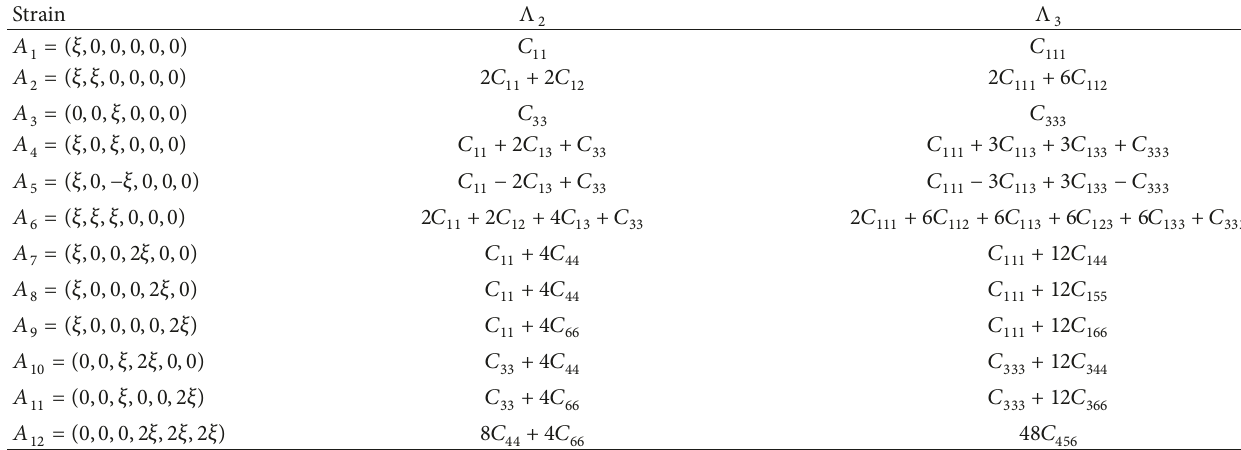
Table 1: Selected strain tensors and the coefficients Λ 2 and Λ 3 in equation (5) as the linear combinations of the second- and third-order elastic constants for tetragonal crystal.